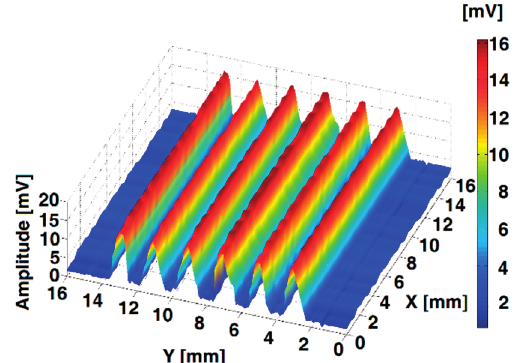
Figure 6. Amplitude of e.m.f. induced in the reception coil at the scanning of silver strip